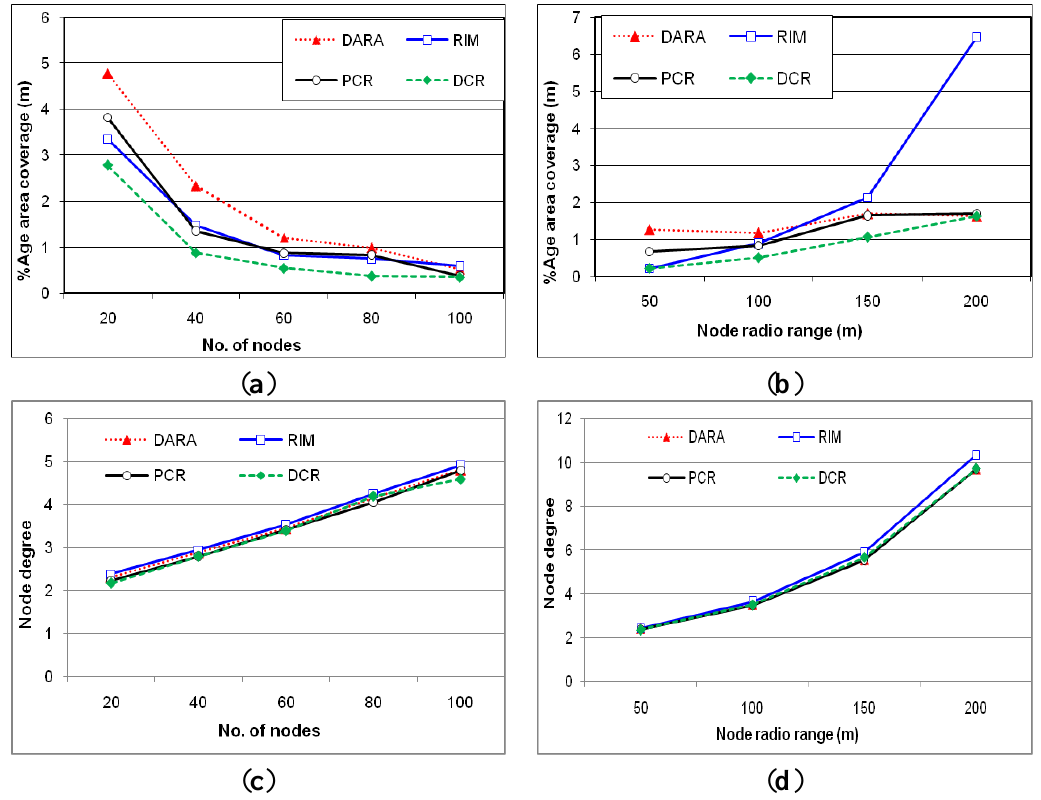
Figure 9. The coverage reduction after recovery, as a function of N in ( a ) and r in ( b ). Degree of connectivity after recovery, while varying the network size ( c ) and radio range ( d